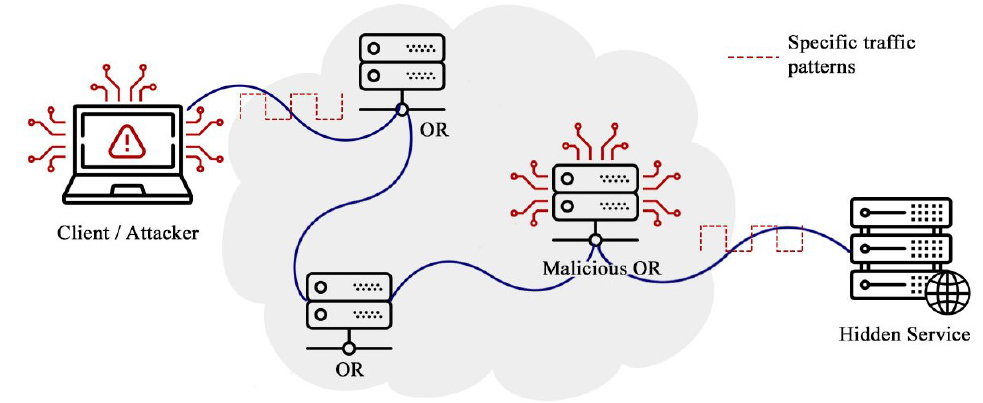
Figure 5. de-anonymisation THS